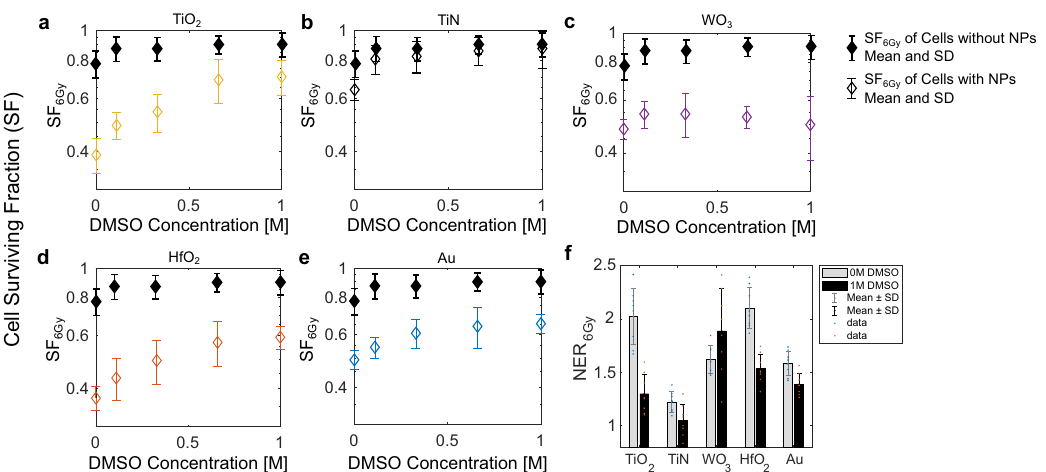
Fig. 6 Radical quenching. Impact of DMSO (hydroxyl radical scavenger) on the surviving fraction (SF) of HT1080 cells with and without nanoparticles after irradiation with 6 Gy of 150 kVp X-rays. Cells have been pre-incubated with 160 µ g/mL TiO 2 ( a ), 80 µ g/mL TiN ( b ), 160 µ g/mL WO 3 ( c ), 320 µ g/mL HfO 2 ( d ), and 40 µ g/mL Au nanoparticles (e) for 24 h before DMSO and X-ray treatment. Monodose nanoparticle enhancement ratio (NER) at 6 Gy without and with 1 M DMSO ( f ). Data in a – f expressed as mean ± SD from n = 8 biological replicates examined over 2 independent CellTiter Glo experiments for each nanoparticle type or to the ones with kV and MV photons, respectively, in line with chemical enhancement results (see Supplementary Fig. 4). Proton